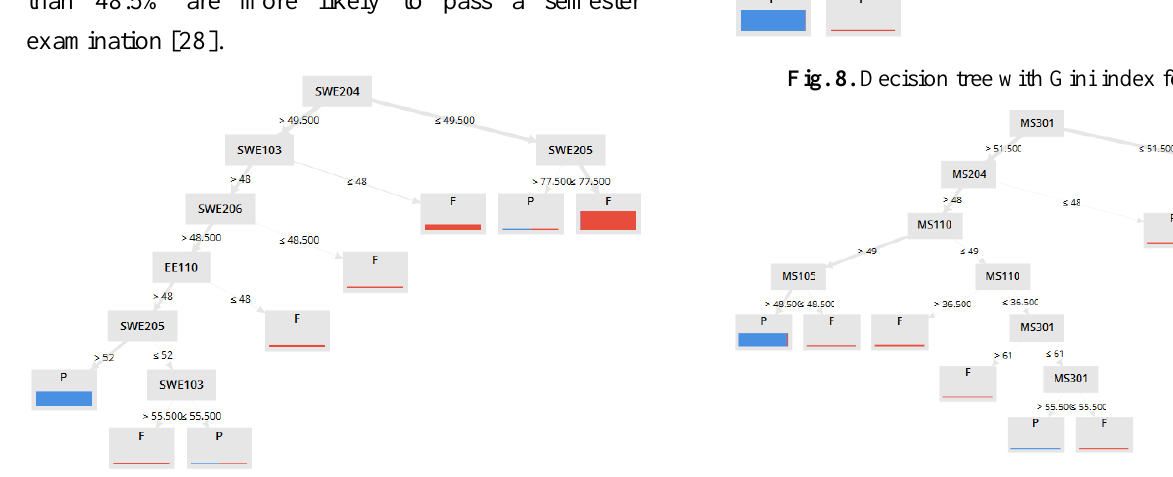
Fig. 9. Decision tree with gain ratio for dataset